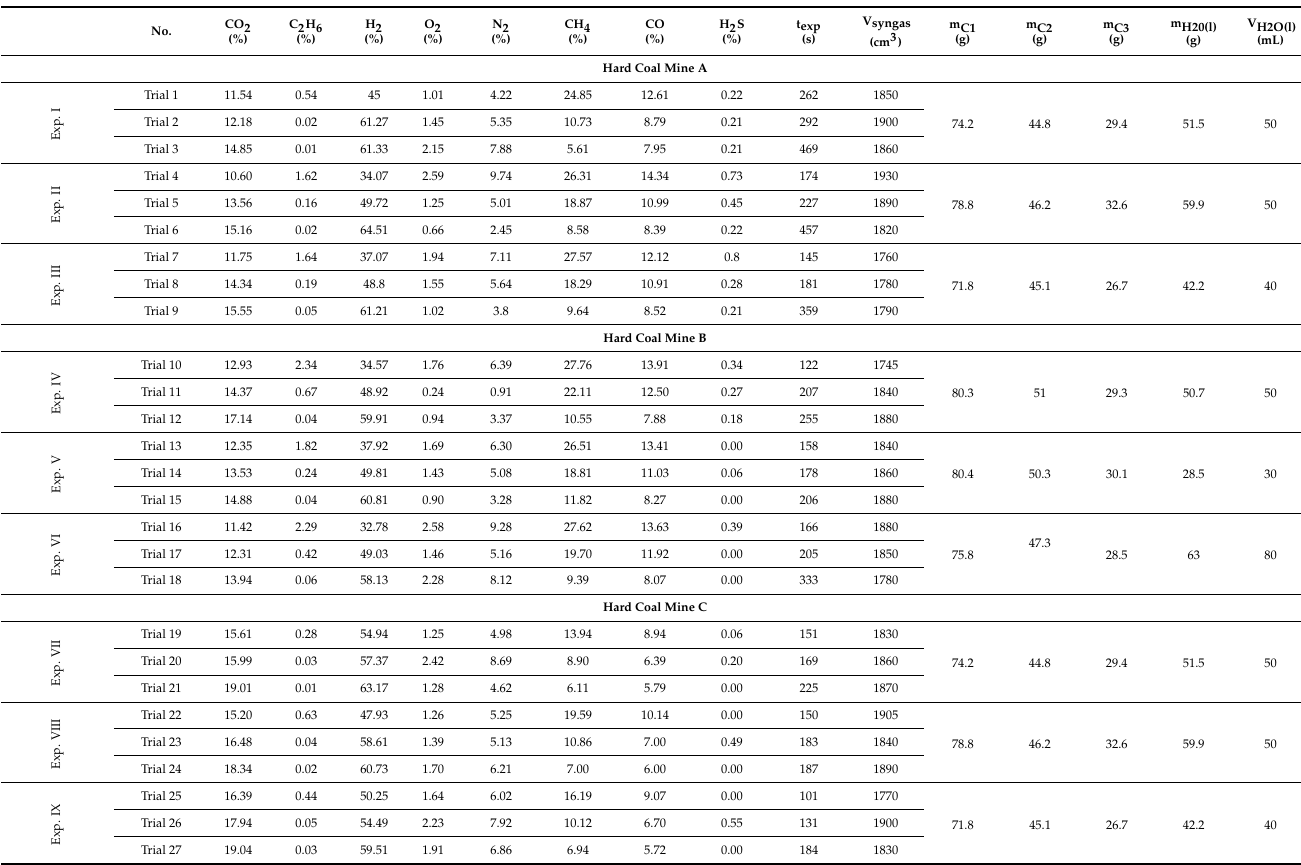
Table 2. Results for a coal sample from hard coal mine A, B,